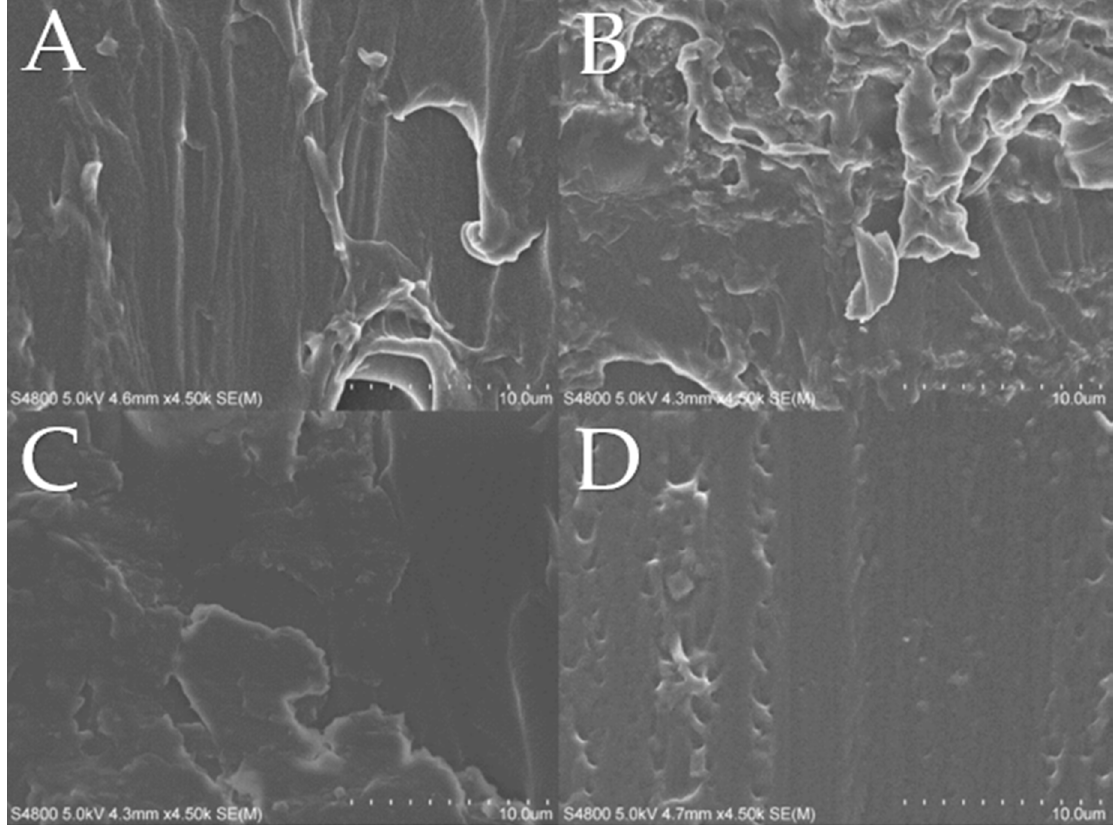
Figure 4. Scanning electron microscopy (SEM) cross-section images of films ( A ) F1, ( B ) F1 / 2ND, ( C ) F1 / C, and ( D ) F1 / C / 2ND. Scale bar = 10 um.